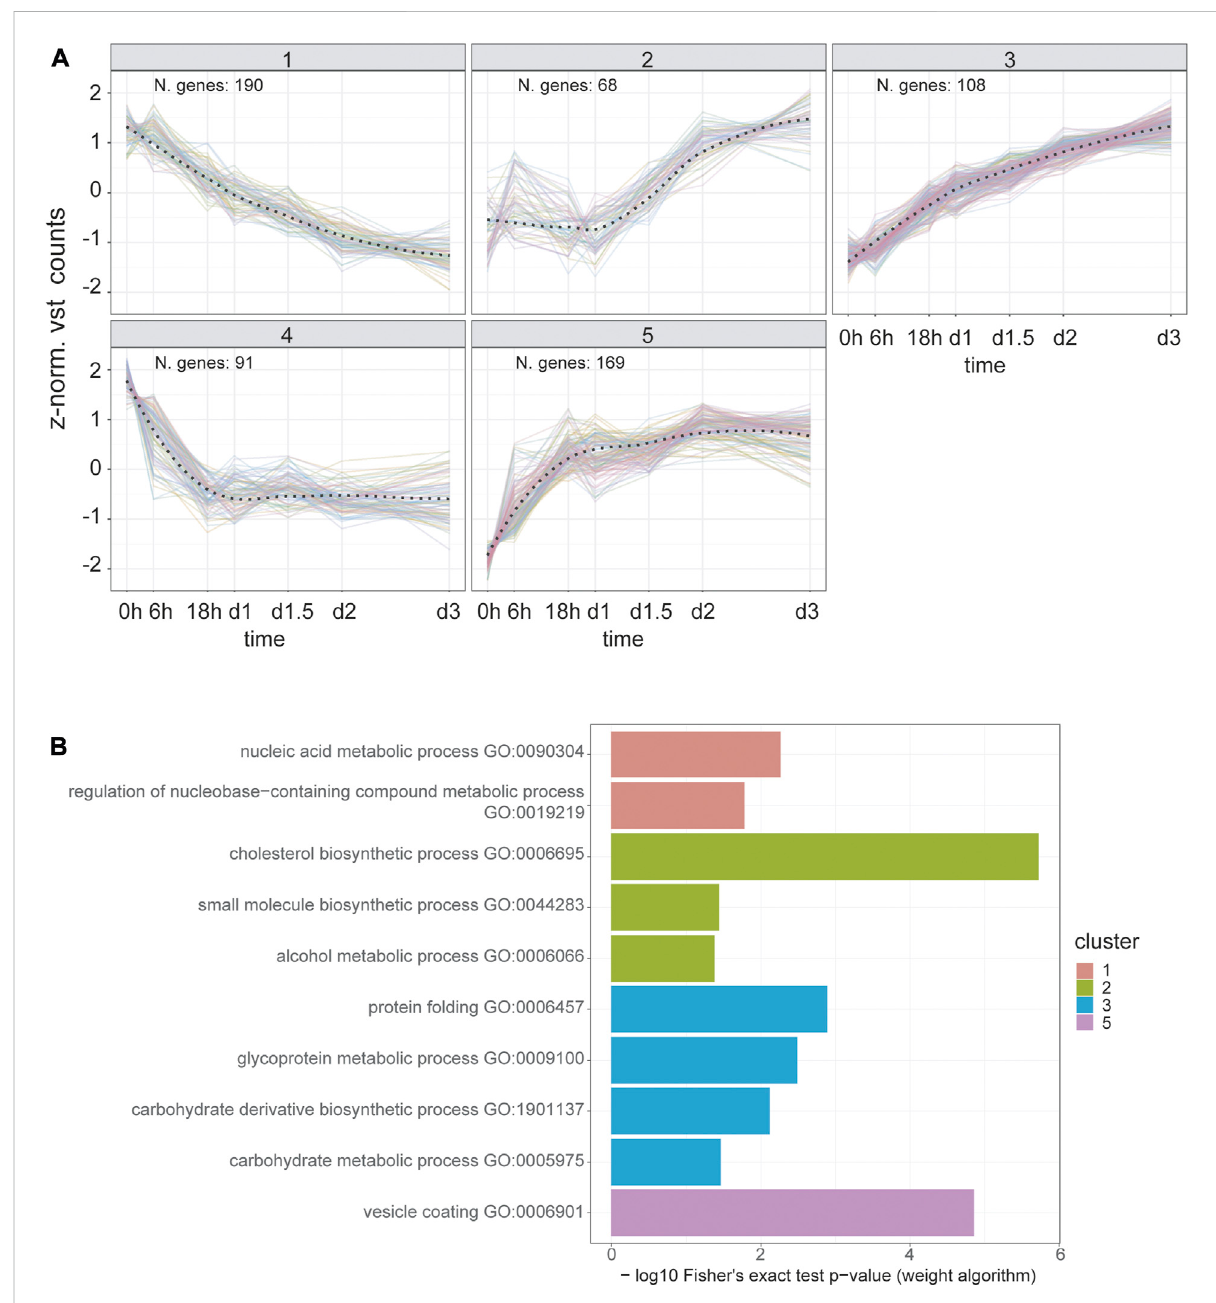
FIGURE 3 Timeseriesclustering dissectsthetemporal orchestrationofERandGolgiapparatusDEGs. (A) TemporalexpressiontrendsforDEGsannotated to “ Golgi Apparatus ” and/or “ EndoplasmicReticulum ” GO cellular component terms. Y -axis represents the z-normalized, averaged expression value transformed using DESEQ2 variance stabilized transformation. The overall trends for each cluster (dashed line) were estimated using a LOESS fi t. (B) Over-representation analysis results for biological process GO terms in each cluster. Fisher ’ s exact test was carried out using the weight algorithm proposed in Alexa et al., 2006, implemented in TopGO. Cluster fi ve shows enrichment for vesicular transport terms, re fl ecting the presence of the main components of COPI, COPII and cargo receptors genes (Supplementary Table 4). Cluster four does not show terms with a signi fi cant enrichment (i.e. p value <